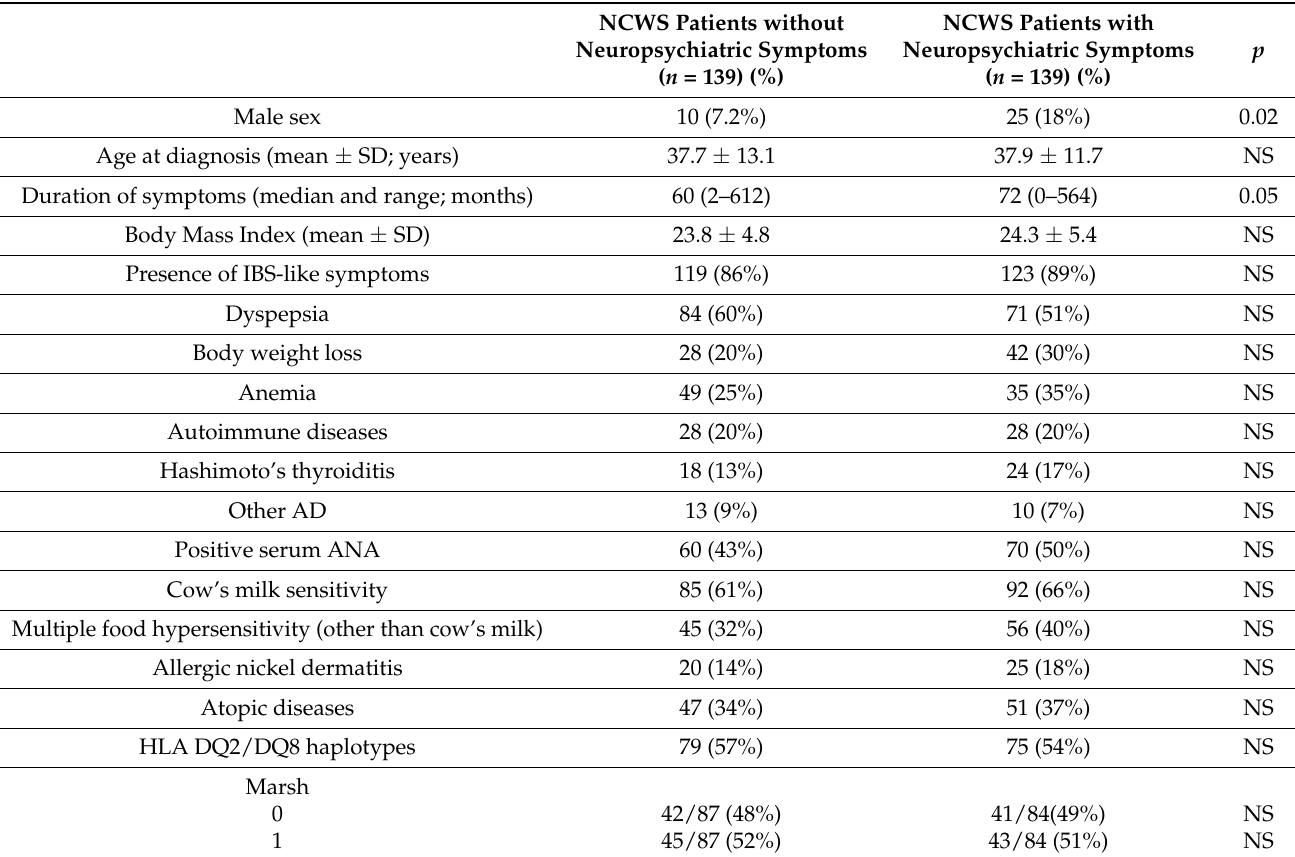
Table 2. Demographic and clinical features of NCWS patients with neurological symptoms compared to NCWS without neurological